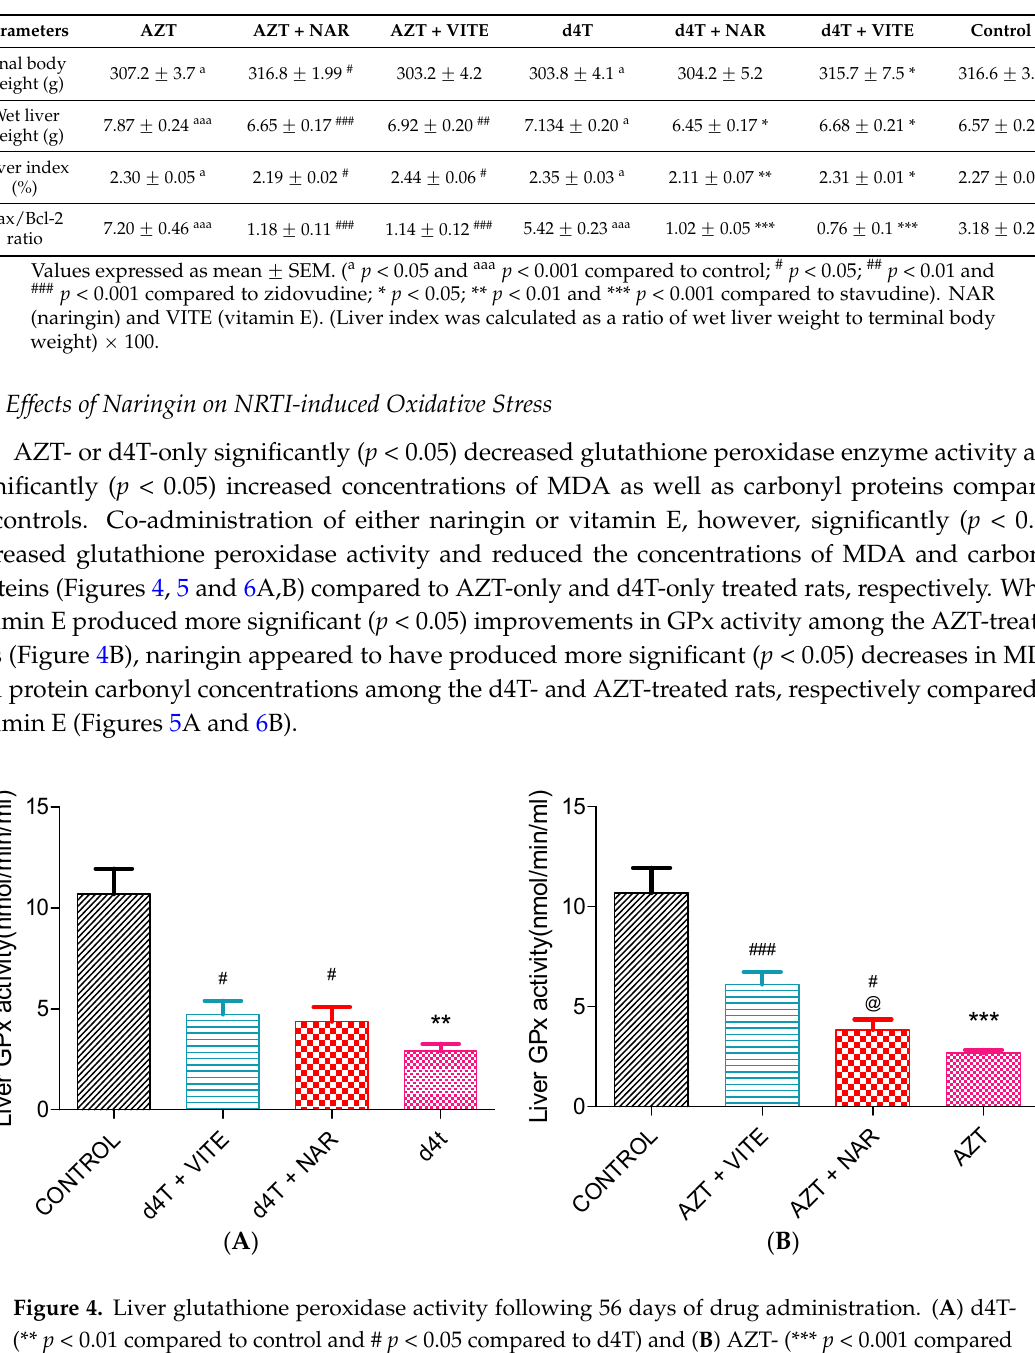
Table 2. Liver and total body weight on day 56; apoptotic index (Bax/Bcl-2 ratio).